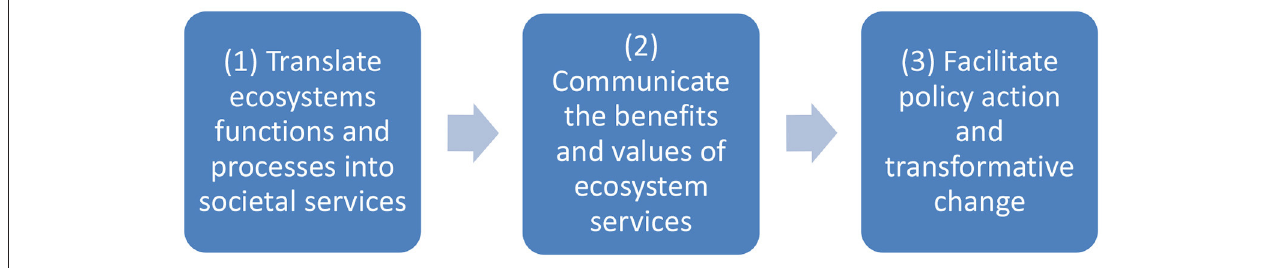
FIGURE 1 | Three interrelated functions of ES to change biodiversity